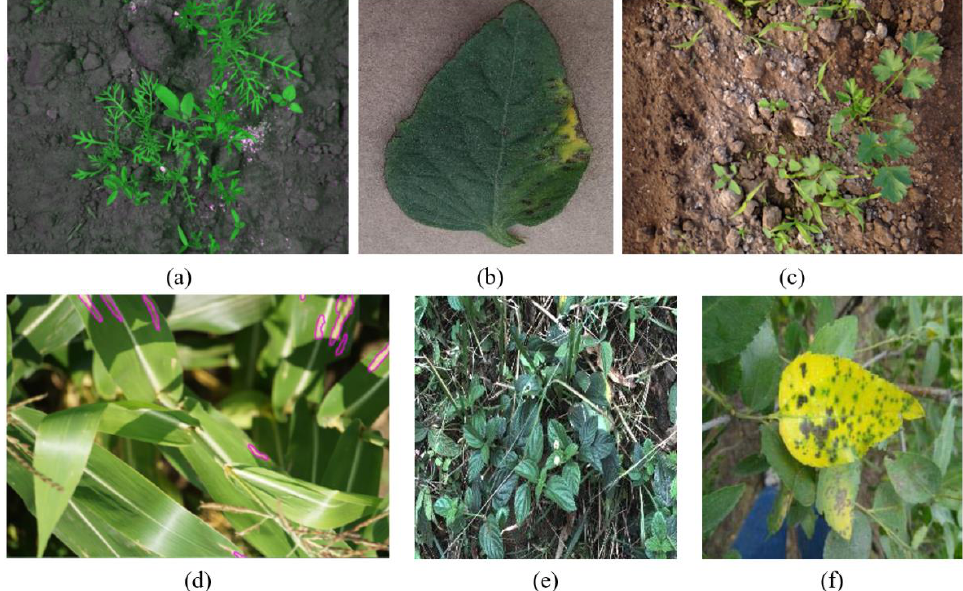
Figure 2. Some examples of public datasets for agriculture sensing at the leaf or canopy scale. ( a ) CWFI (60 images) [120]. ( b ) PlantVillage (54,309 images) [39]. ( c ) Carrot-Weed (39 images) [121]. ( d ) MaizeDisease (18,222 images) [122]. ( e ) DeepWeeds (17,509 images) [68]. ( f ) PDD 217 (220,592 im- ages) [124].